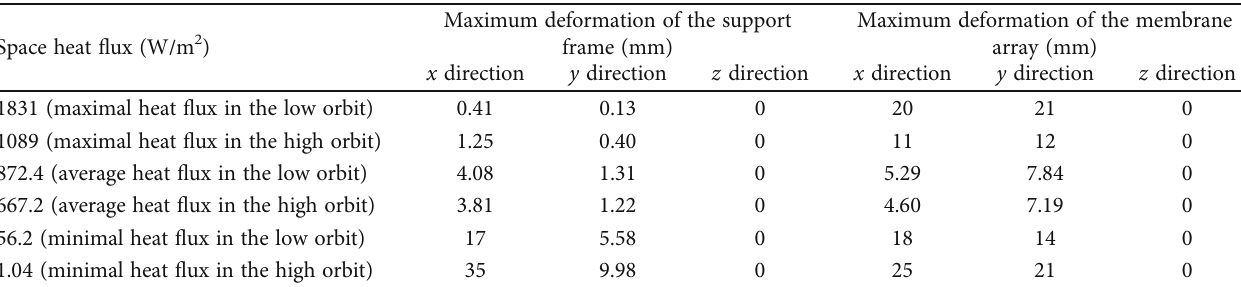
Figure 8: Temperature vs. time graph of the membrane antenna structure in high orbit: (a) support frame; (b) membrane array. Table 3: Thermal deformation of the membrane antenna structure.